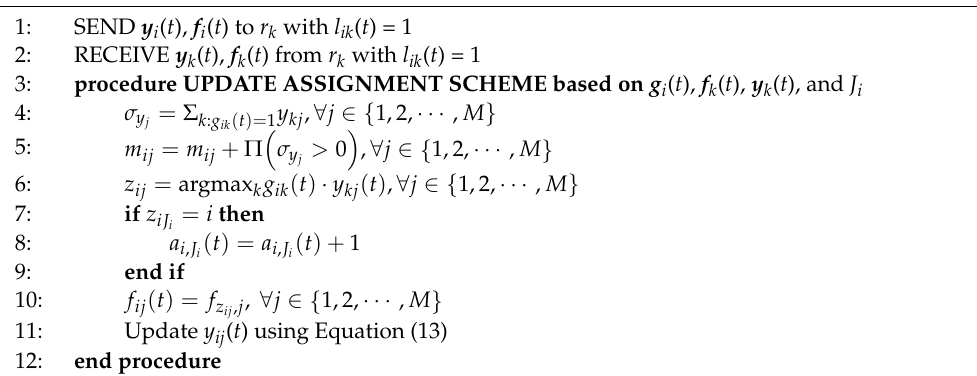
Algorithm 2: The MTCBAA consensus phase of an agent r i at an iteration